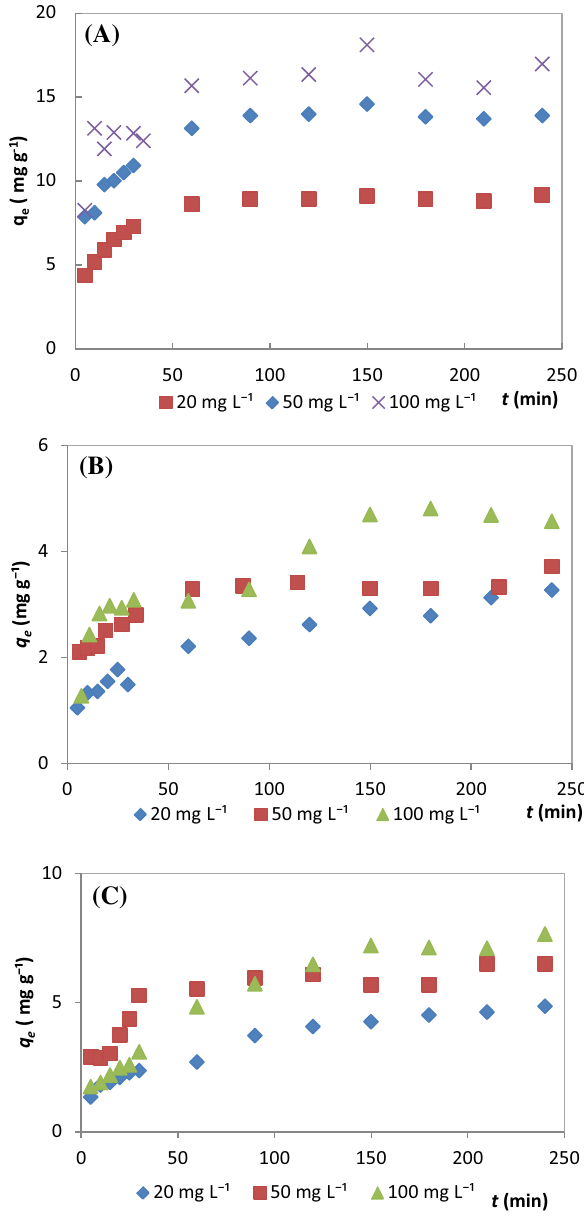
Fig. 4 The adsorption of AB25 as function of time by a WL, b TP and c